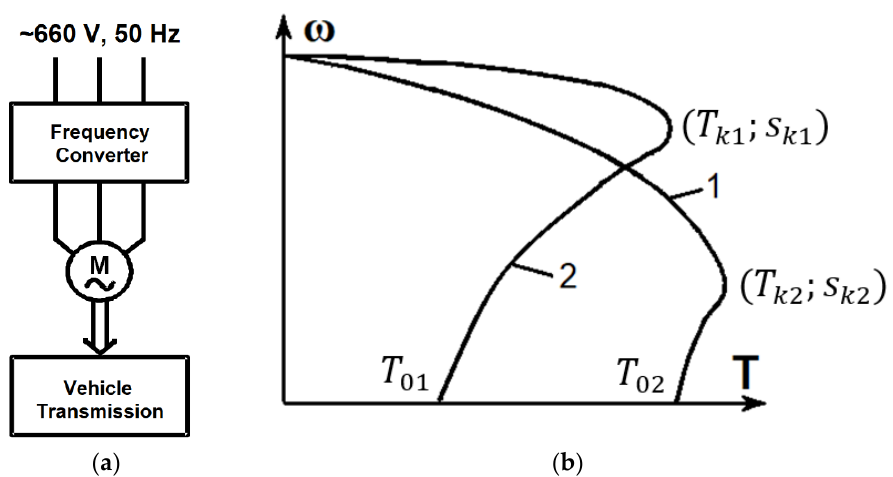
Figure 2. Functional diagram of the traction drive ( a ) and mechanical characteristics of electric motors ( b ): 1—traction motor, 2—motor for frequency